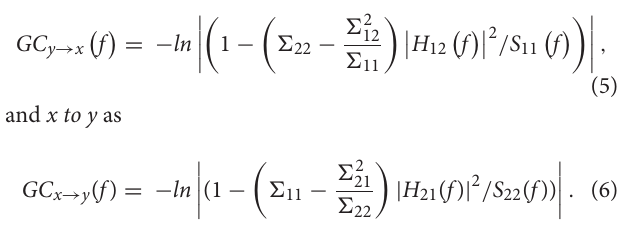
where H is the transfer matrix with H =